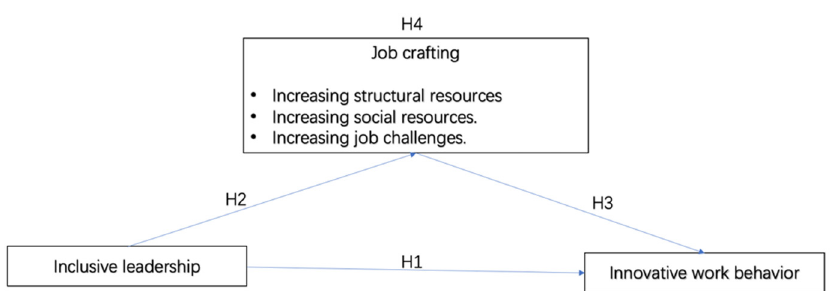
Figure 1. Conceptual framework.